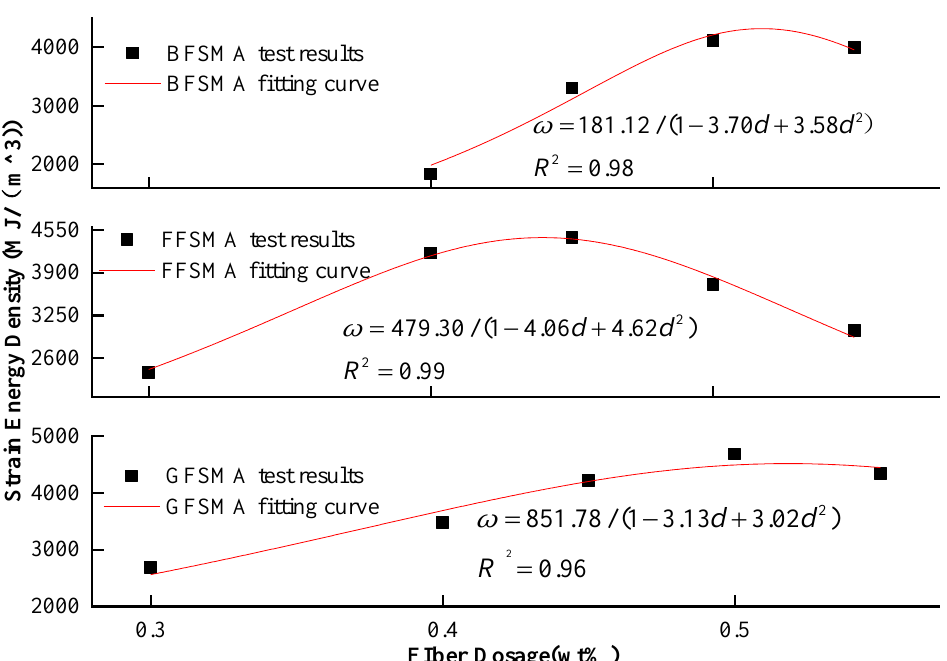
Figure 12. Fitting between fiber dosage and strain energy density.